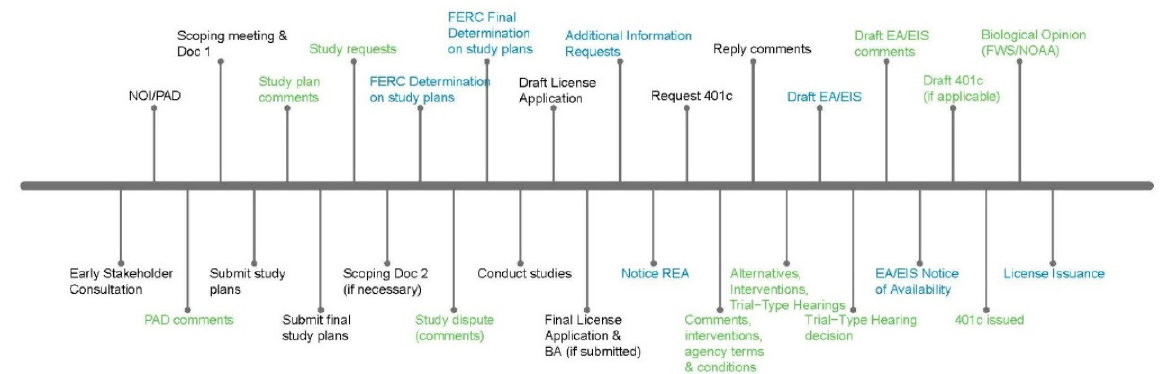
Figure 2. Example timeline showing the relative order of FERC hydropower licensing milestones for the ILP, with milestones completed by the license applicant (black), stakeholders/regulators (green), and FERC (blue). The total number of years, and years taken between each step, vary by project.